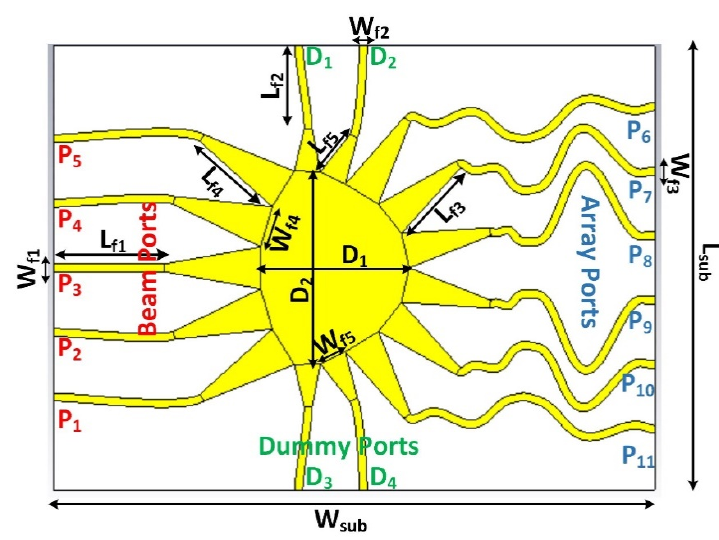
Figure 2. Geometric design of the proposed Rotman lens sensor.